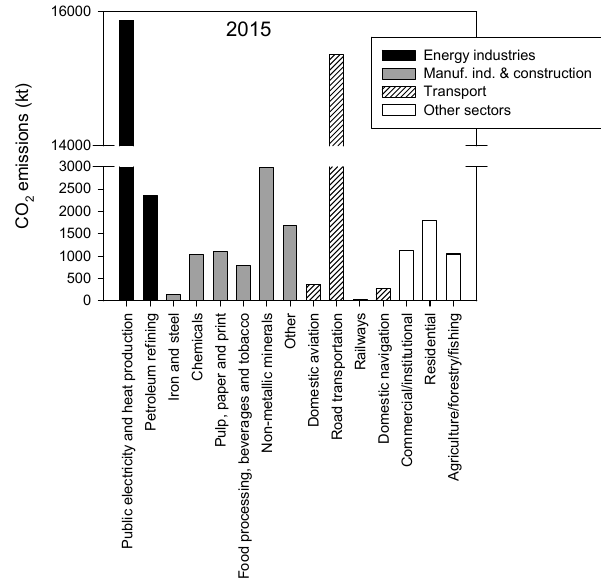
Figure 10. CO 2 emissions due to energy production by sector (2015) (adapted from [40]).